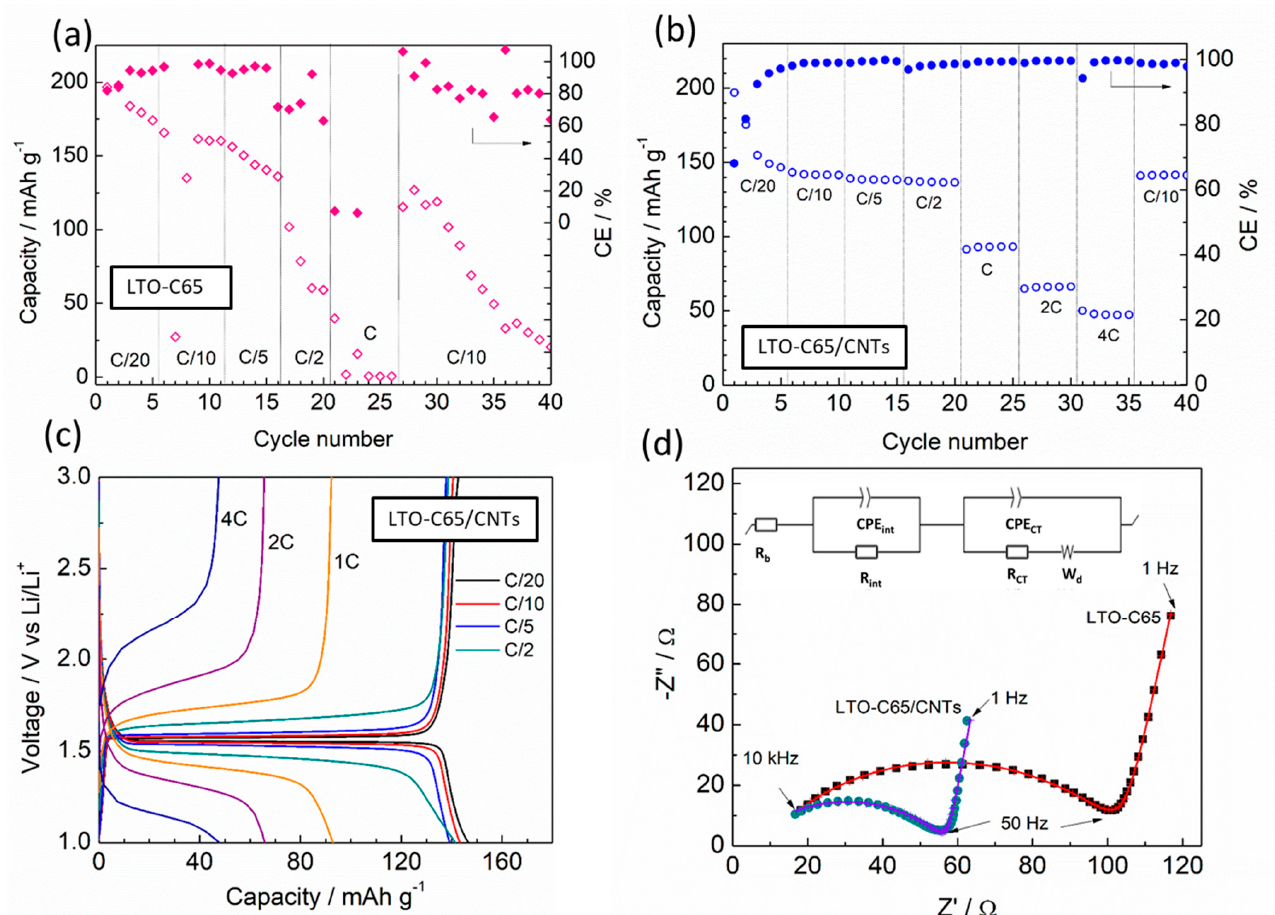
Figure 2. Rate capability of ( a ) LTO-C65 and ( b ) LTO-C65/CNTs half-cells with PEO-LiTFSI polymer electrolyte and Li metal anode measured at 70 °C. ( c ) Charge–discharge voltage profile of the LTO-C65/CNTs cell from C/20 to 4C. ( d ) Nyquist plots (dots) and equivalent circuit (lines) of the LTO-C65 and LTO-C65/CNTs cells after conditioning 24 h at 70 °C. Table 1. Resistances of the different components obtained from the Li metal full cells assembled with the two electrodes: ionic bulk conductivity (R b ), electrode interfaces (R int ), cathode solid elec-